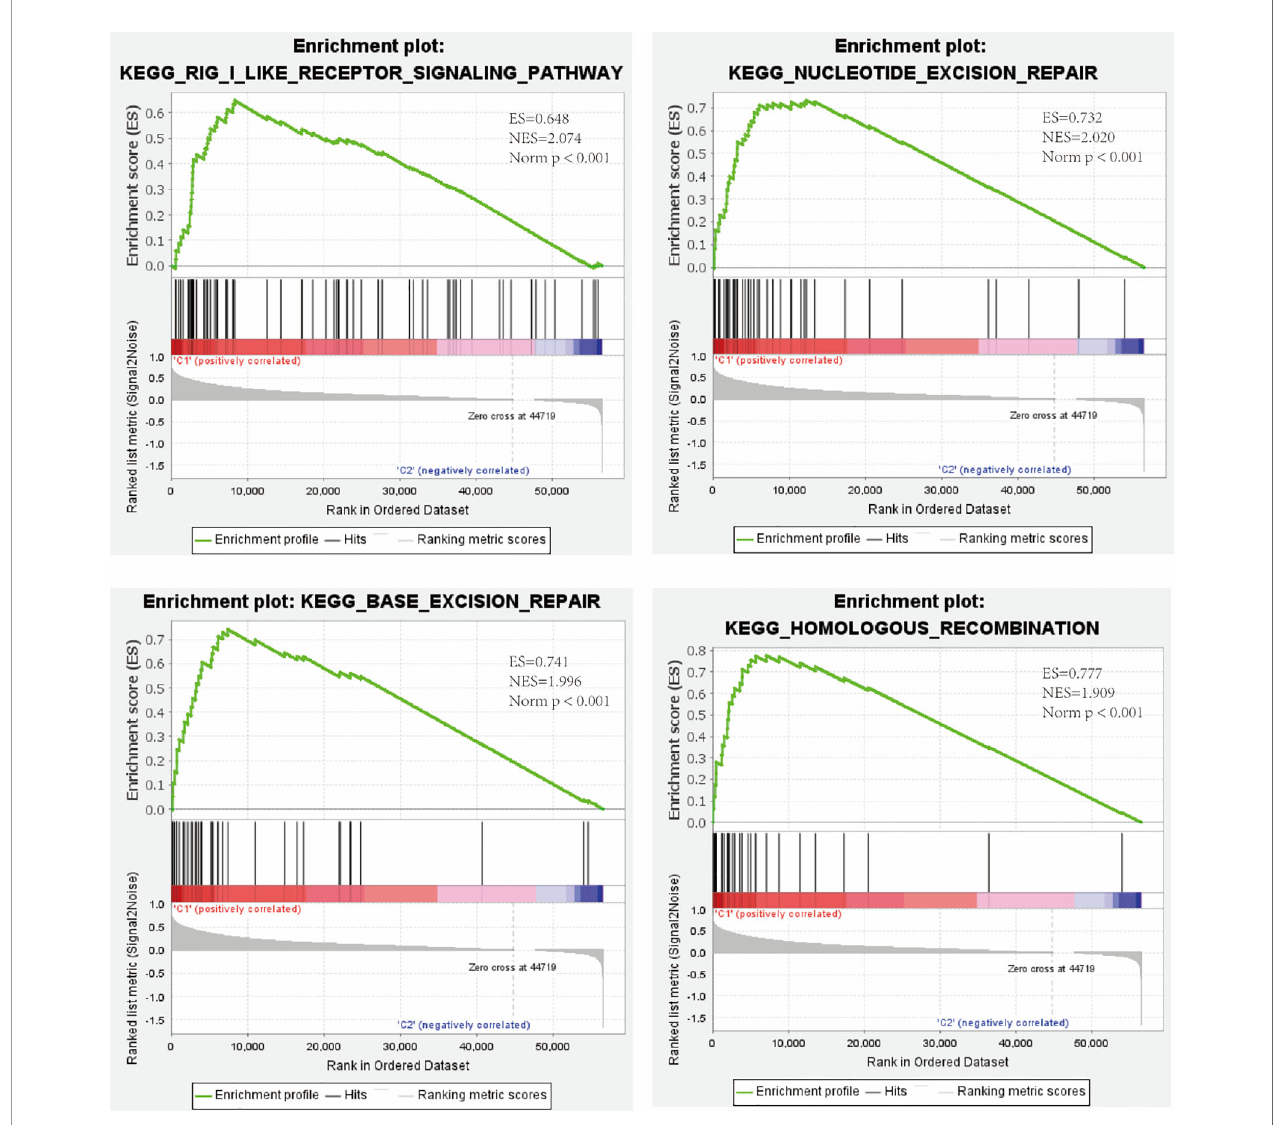
FIGURE 5 | Enrichment of the RIG-I-like receptor signaling pathway and three types of DNA repair pathways in the high-risk group as revealed by GSEA. ES, enrichment score; NES, normalized enrichment score; Norm p , Nominal